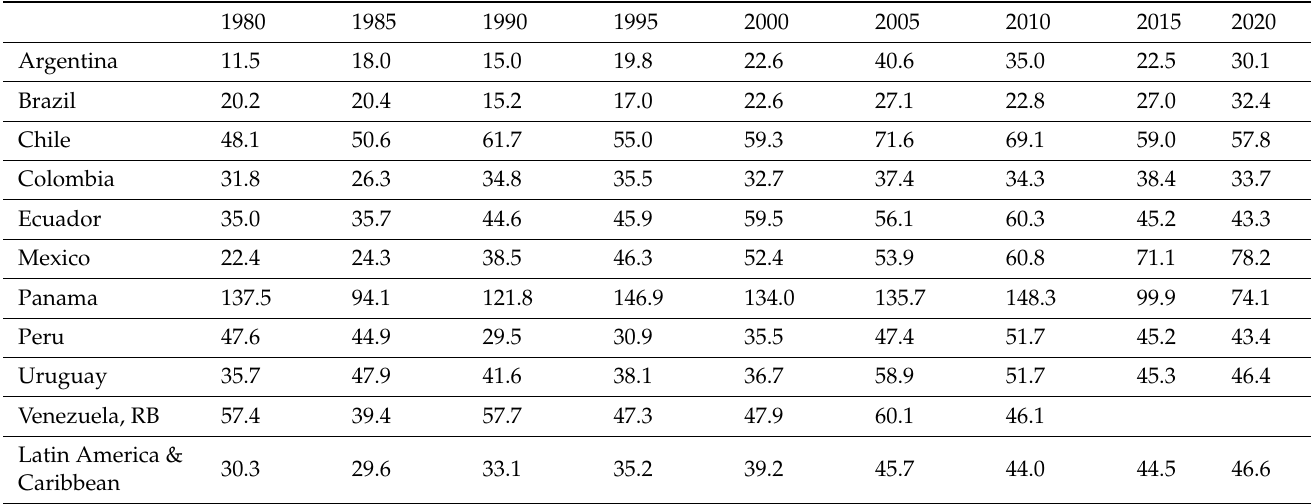
Table 4. Trade openness index since 1980 (in intervals of 5 years) for the countries in this study and the average in Latin America and the